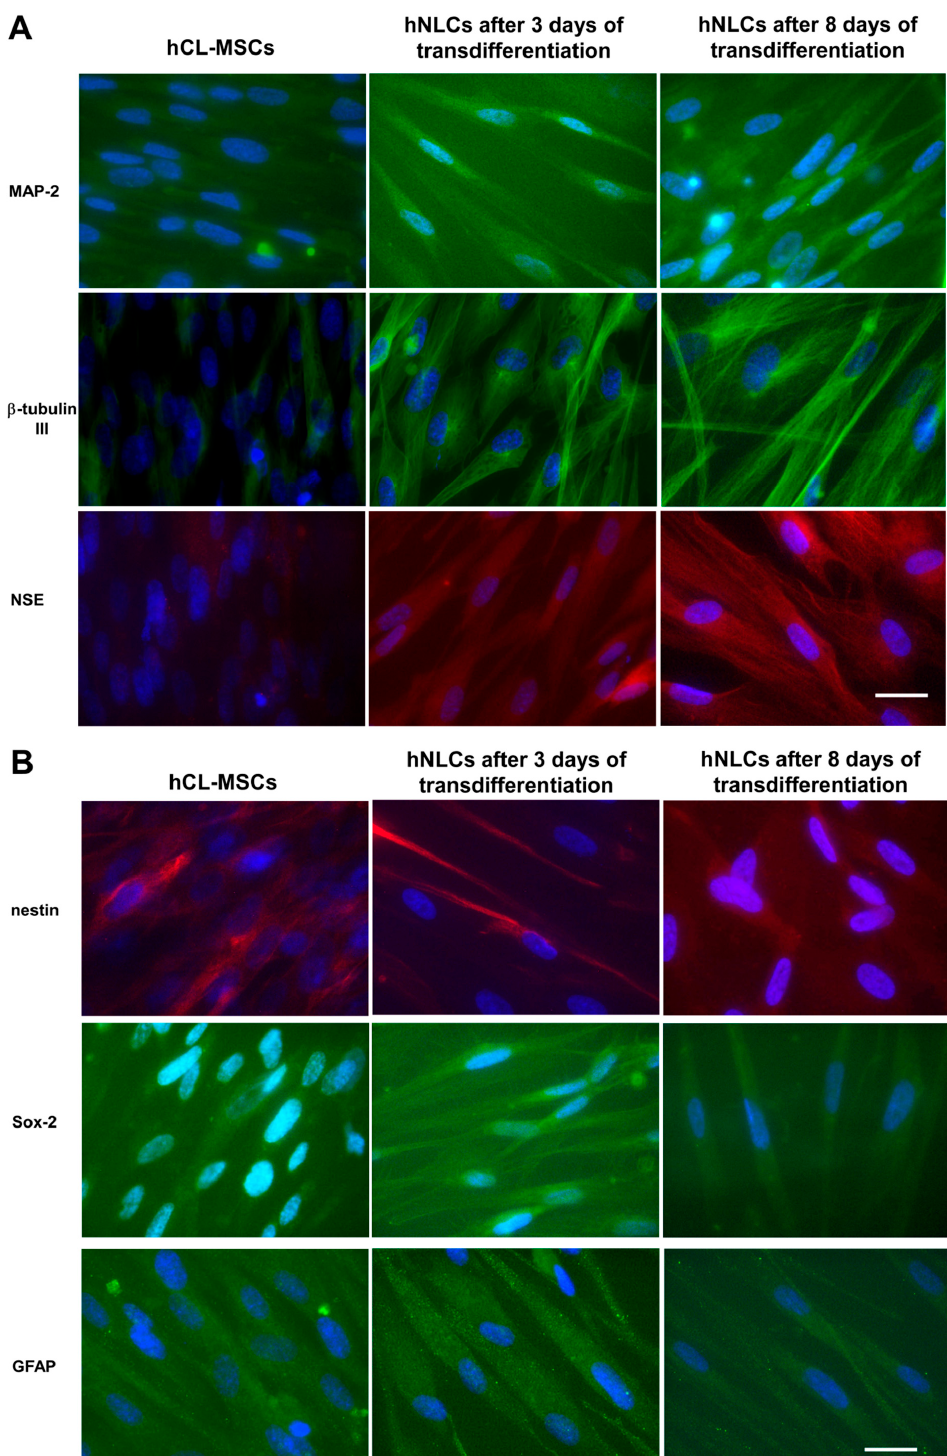
Figure 4. Immunofluorescence characterization of transdifferentiated hNLCs at different time points. ( A ) Representative fluorescence merged microphotographs showing MAP-2- and β -tubulin III-positive (green fluorescence) and enolase-positive (red fluorescence) in hCL-MSCs and transdifferentiated hNLCs at day 3 and 8, ( B ) microphotographs showing nestin-positive (red fluorescence), SOX-2-, and GFAP-positive (green fluorescence) in hCL-MSCs and transdifferentiated hNLCs at day 3 and 8. Nuclei were stained with Hoechst 33258. Scale bar: 100 μ m.